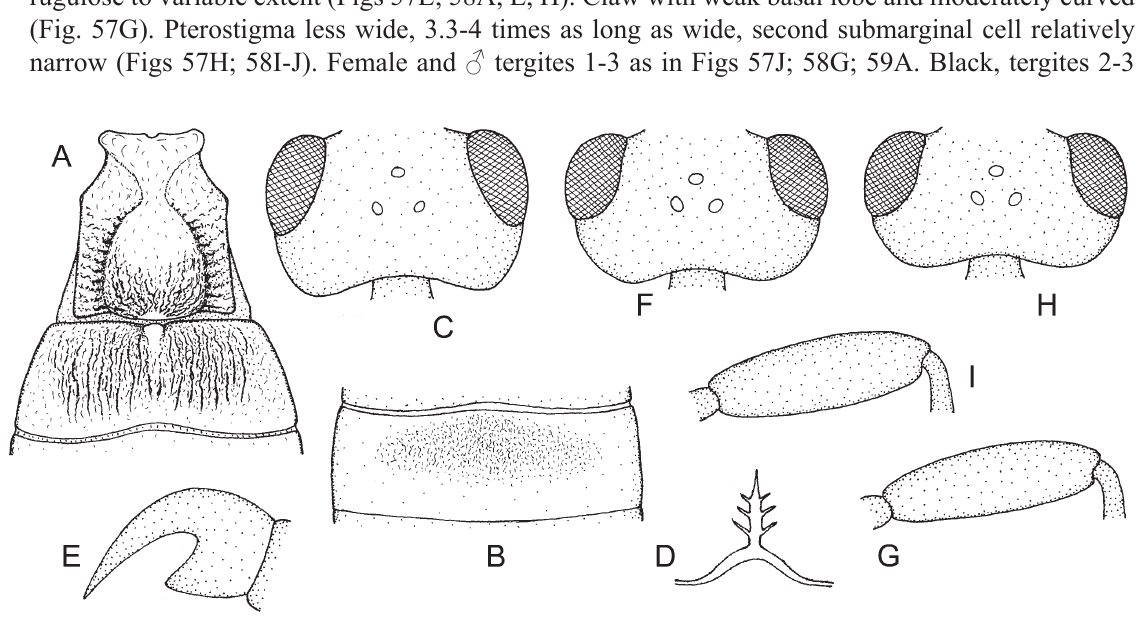
Fig. 59. — A-C . Bracon ( Glabrobracon ) exhilarator Nees, 1834, ♀. A . Tergites 1-2. B . Second tergite. C . Head in dorsal view. — D-E . Bracon ( Glabrobracon ) curticaudis Szépligeti, 1901, ♀